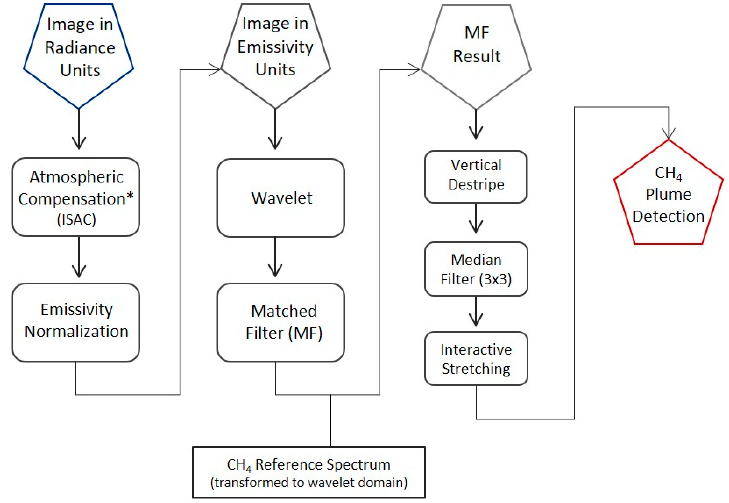
Figure 2. Diagram of the methodology applied for the detection of CH 4 plumes. * Adaptation of the in-scene atmospheric compensation algorithm [18].